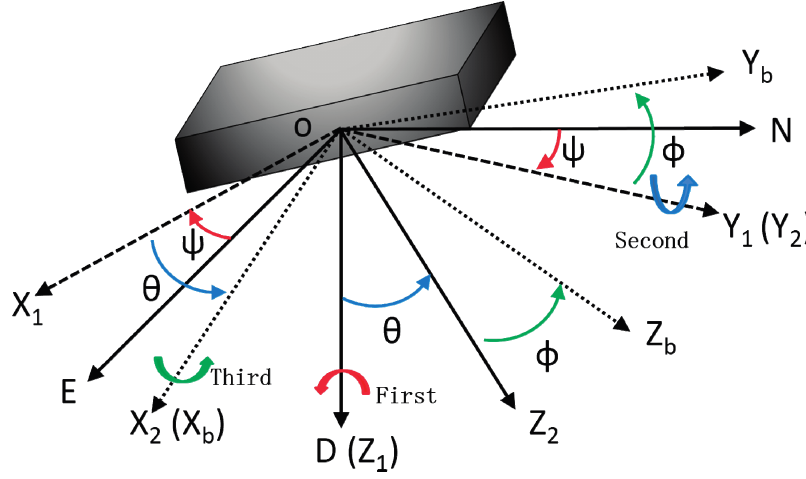
Figure 2. Transformation between NED and body coordinate